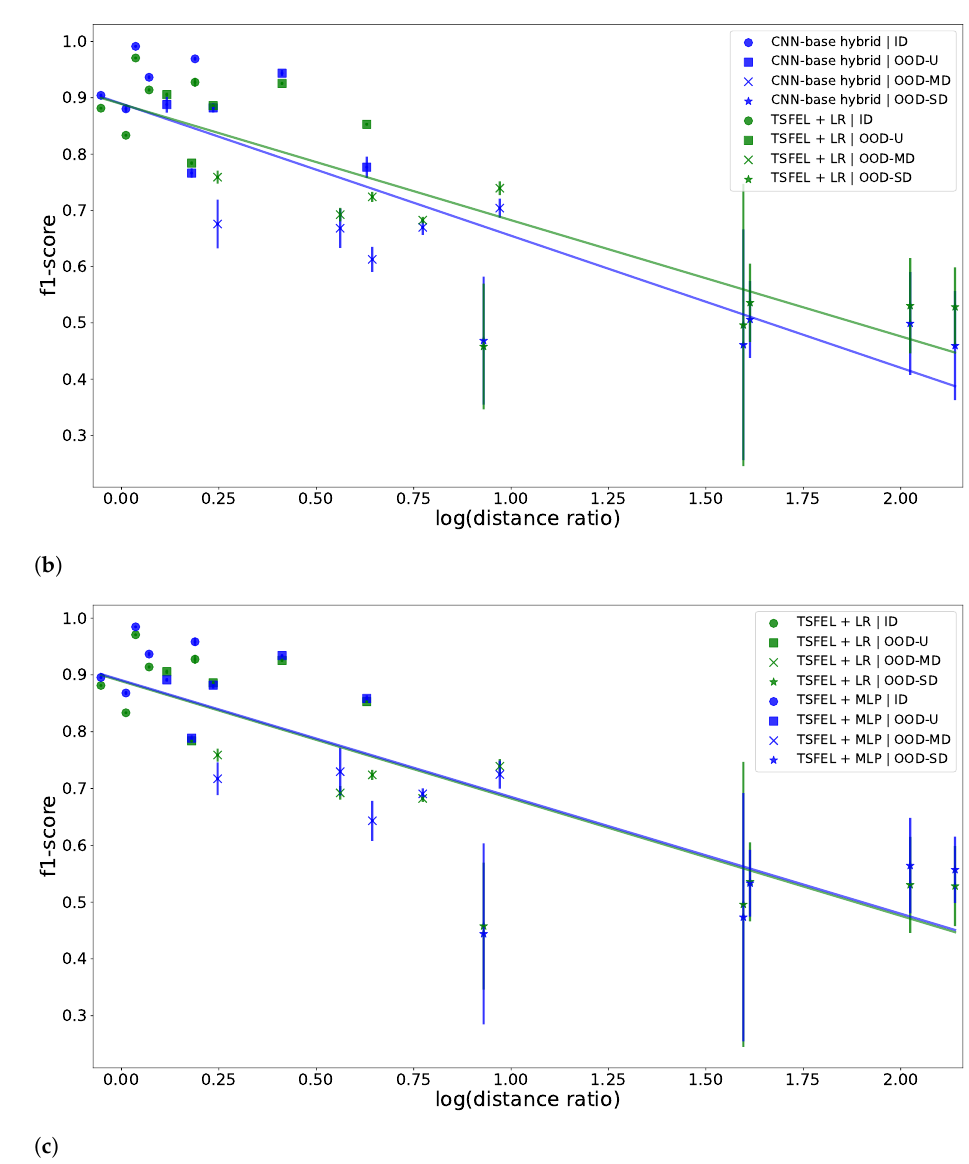
Figure A1. F1-score vs. log(distance ratio). Each marker represents a different task. Distance ratios are based on the CNN-base embeddings. Error bars represent one standard deviation away from the mean. ( a ) TSFEL + LR vs. ResNet. ( b ) TSFEL + LR vs. CNN-base hybrid. ( c ) TSFEL + LR vs. TSFEL +